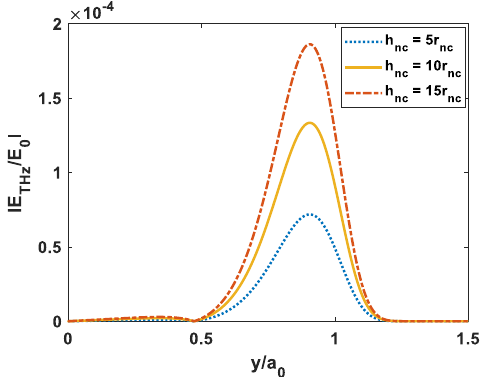
Figure 7. Spatial profile of emitted THz radiations with normalized distance from axis of beam for different values of height of nanocylinders with their basal planes parallel to the electric field of laser beams, when 𝑑 𝑛𝑐 = 6𝑟 𝑛𝑐 , 𝐸 0 = 4.0 × 10 10 V/m , 𝑎 0 = 2.0 × 10 −5 m, 𝜔 ′ = 1.884 × 10 14 rad/s and 𝜔 ′′ = 1.811 × 10 14 rad/s .